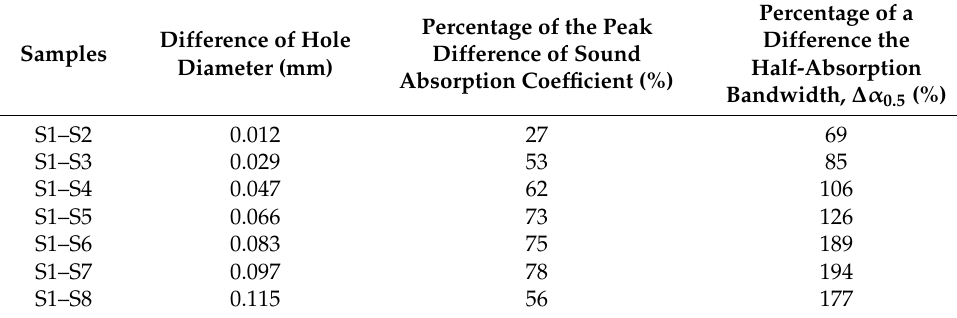
Table 5. Absorption performance difference between Table 5 . Absorption performance difference between samples .